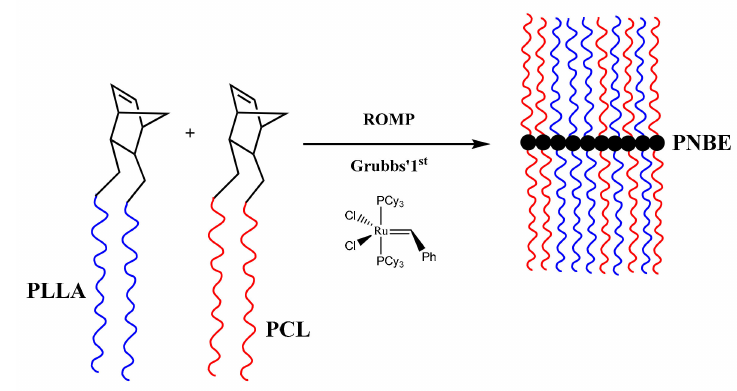
Figure 9. Synthesis of